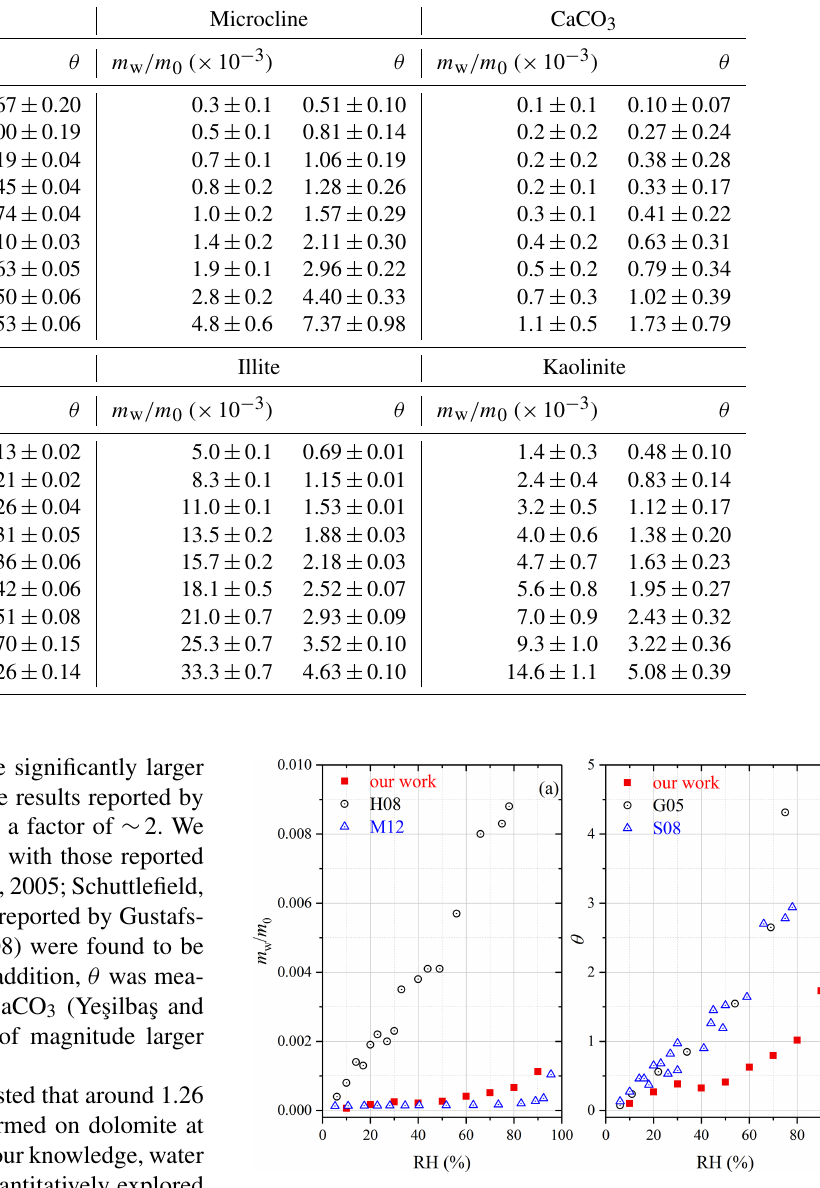
Table 3. Mass ratios of adsorbed water to the dry mineral ( m w /m 0 ) and surface coverages of adsorbed water ( θ ) as a function of RH (%) for albite, microcline, CaCO 3 , dolomite, illite and kaolinite.